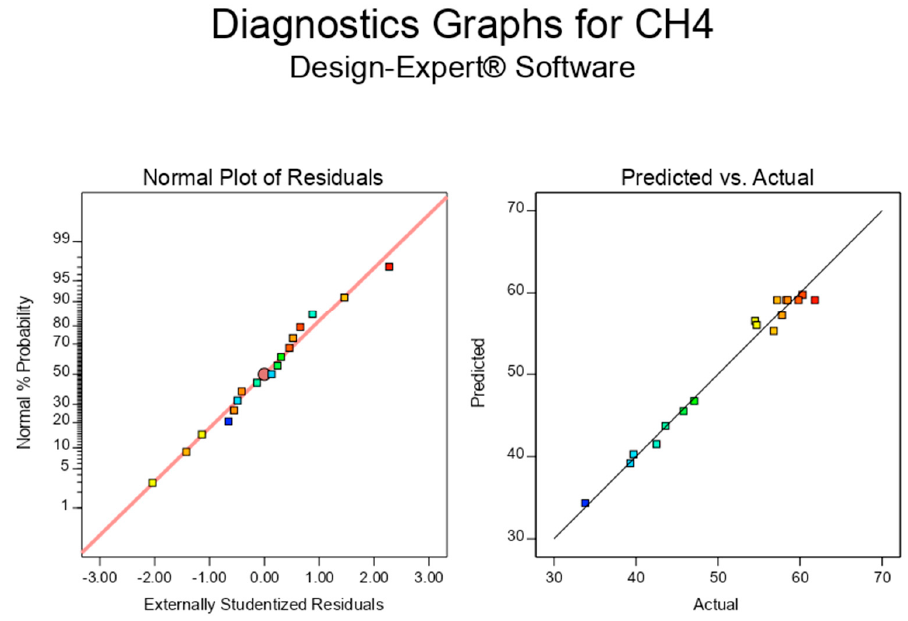
Figure 3. Normal probability and predicted vs. actual residual plots of CH 4 % produced from CP.